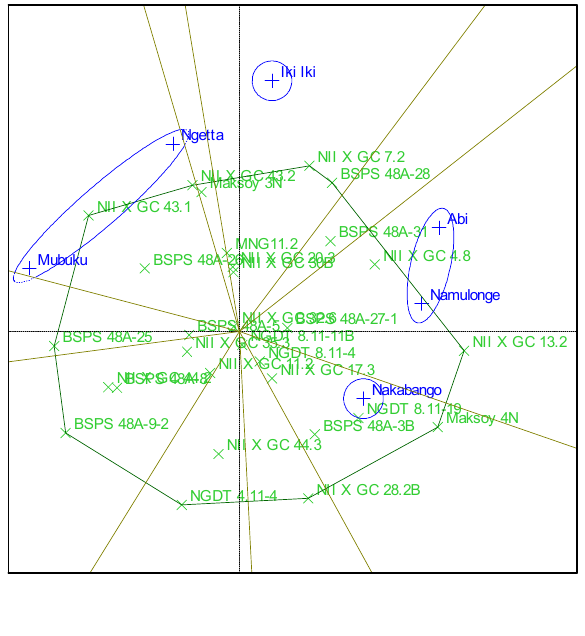
Figure 2. A GGE ranking biplot showing the mean performance and stability for the protein contents of 30 soybean genotypes evaluated in six locations.